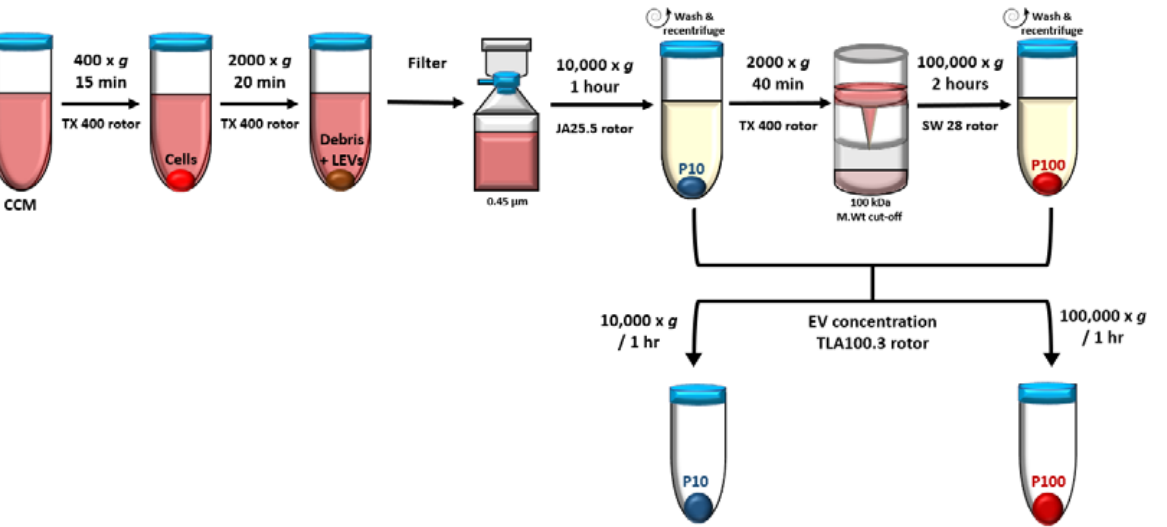
Figure 2. EVs were isolated by differential centrifugation including a filtration and concentration step. Medium speed centrifugation at 10,000× g and high-speed ultracentrifugation at 100,000× g was used to pellet EVs designated P10 and P100, respectively. CCM—conditioned culture media, LEV—large